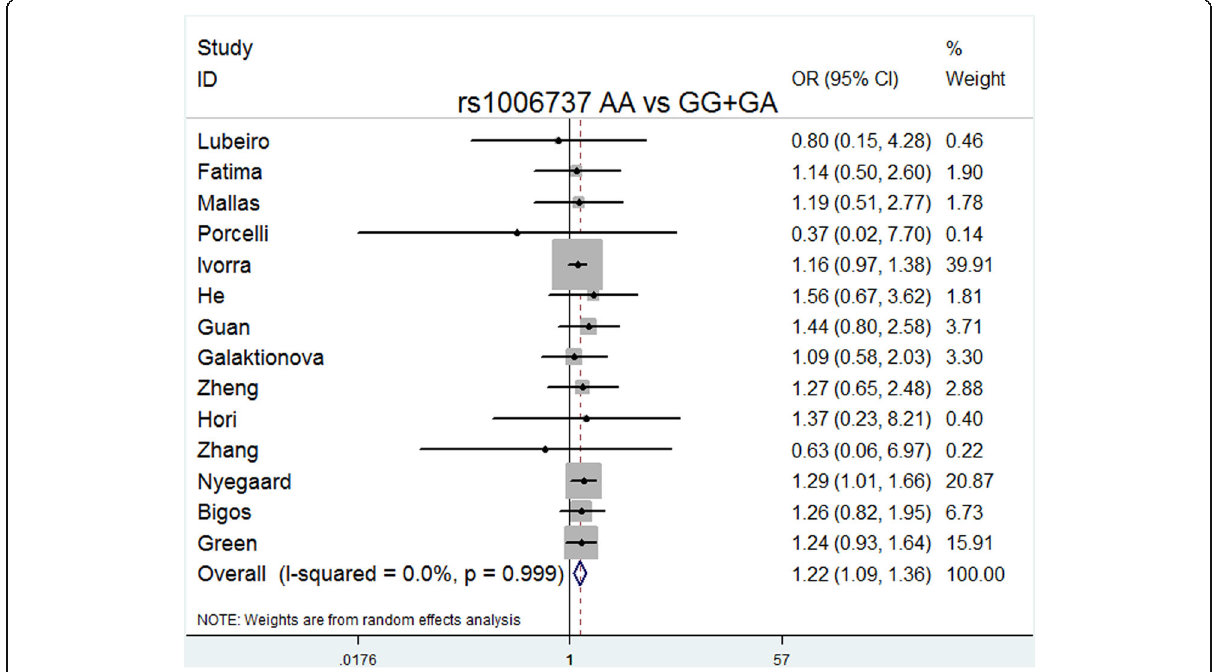
Fig. 4 Forest plot of the recessive model (AA vs. GG + GA) for rs1006737. Significant differences between rs1006737 and the risk of schizophrenia were observed with the recessive model (AA vs. GG + GA) (OR = 1.215, 95% CI = 1.085 – 1.360, P heterogeneity = 0.999, P = 0.001)